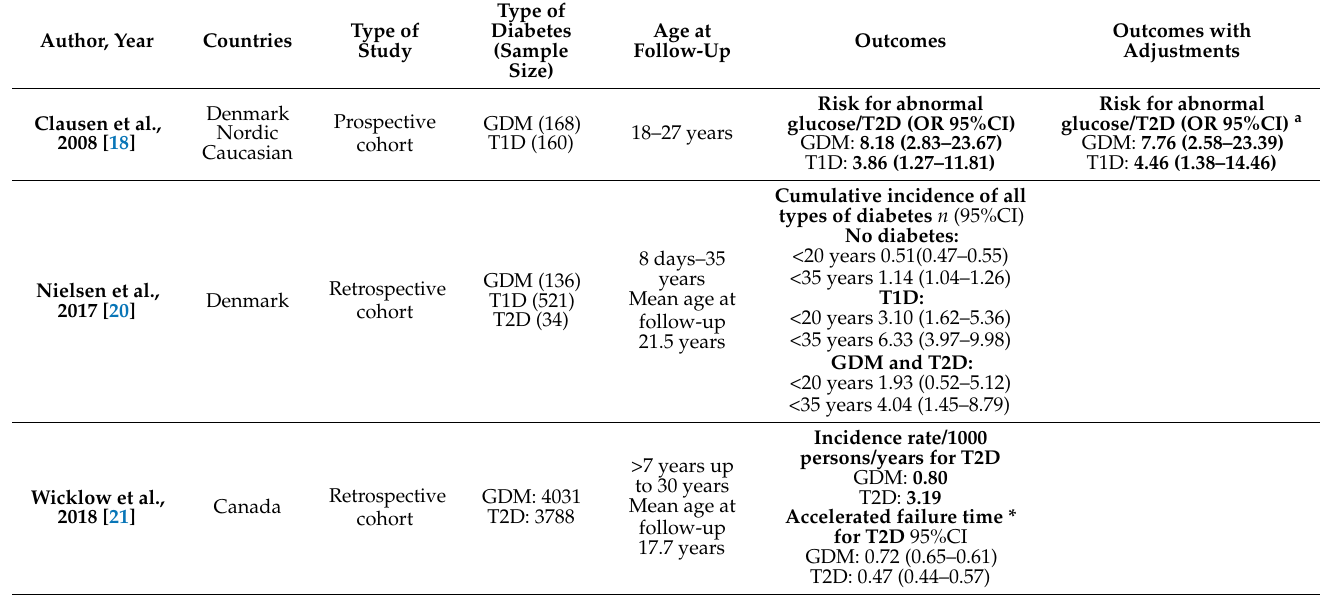
Table 2. Risk for type 2 diabetes or abnormal glucose according to the type of maternal diabetes during